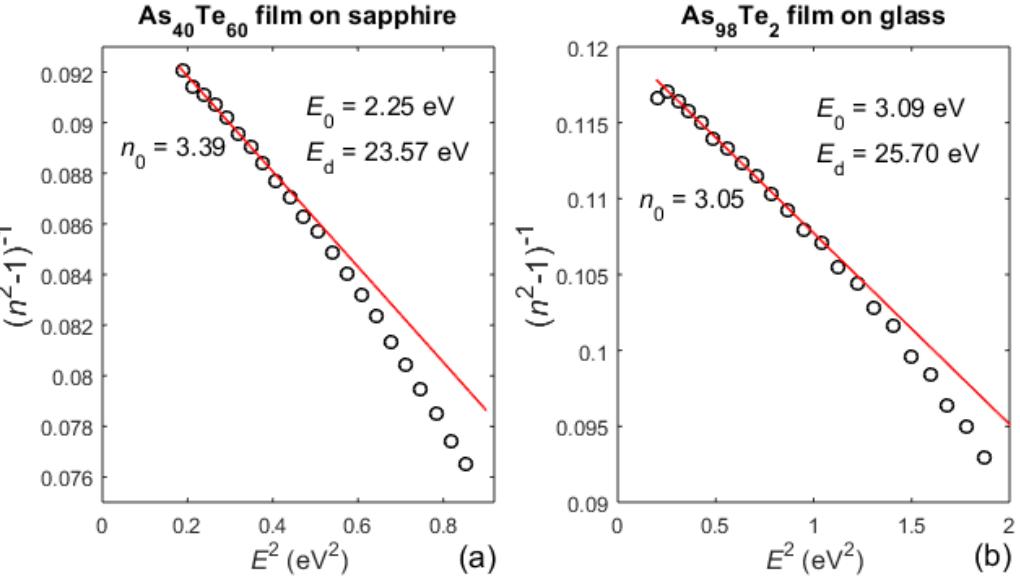
Figure 7. Wemple–DiDomenico (WD) plots. ( a ) for the As 40 Te 60 film, ( b ) for the As 98 Te 2 film. The low-energy linear regression to the WD plot is represented by red line. n {min( E ( λ t ))} is disregarded from the linear regression from Figure 7b due to its arguable inaccuracy, since only max( λ t ) is in the region of strong substrate absorption.